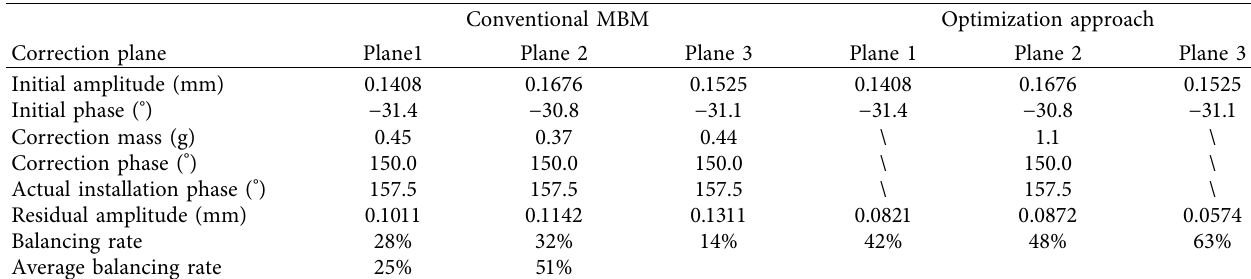
Table 4: Comparison of different methods for the rotor balancing at the first critical